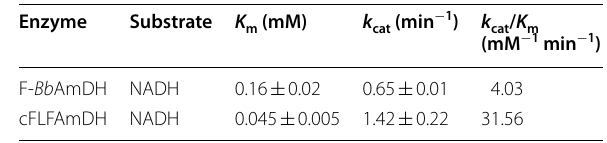
Table 2 Kinetic parameters of chimeric amine dehydrogenase and F- Bb AmDH for substrate